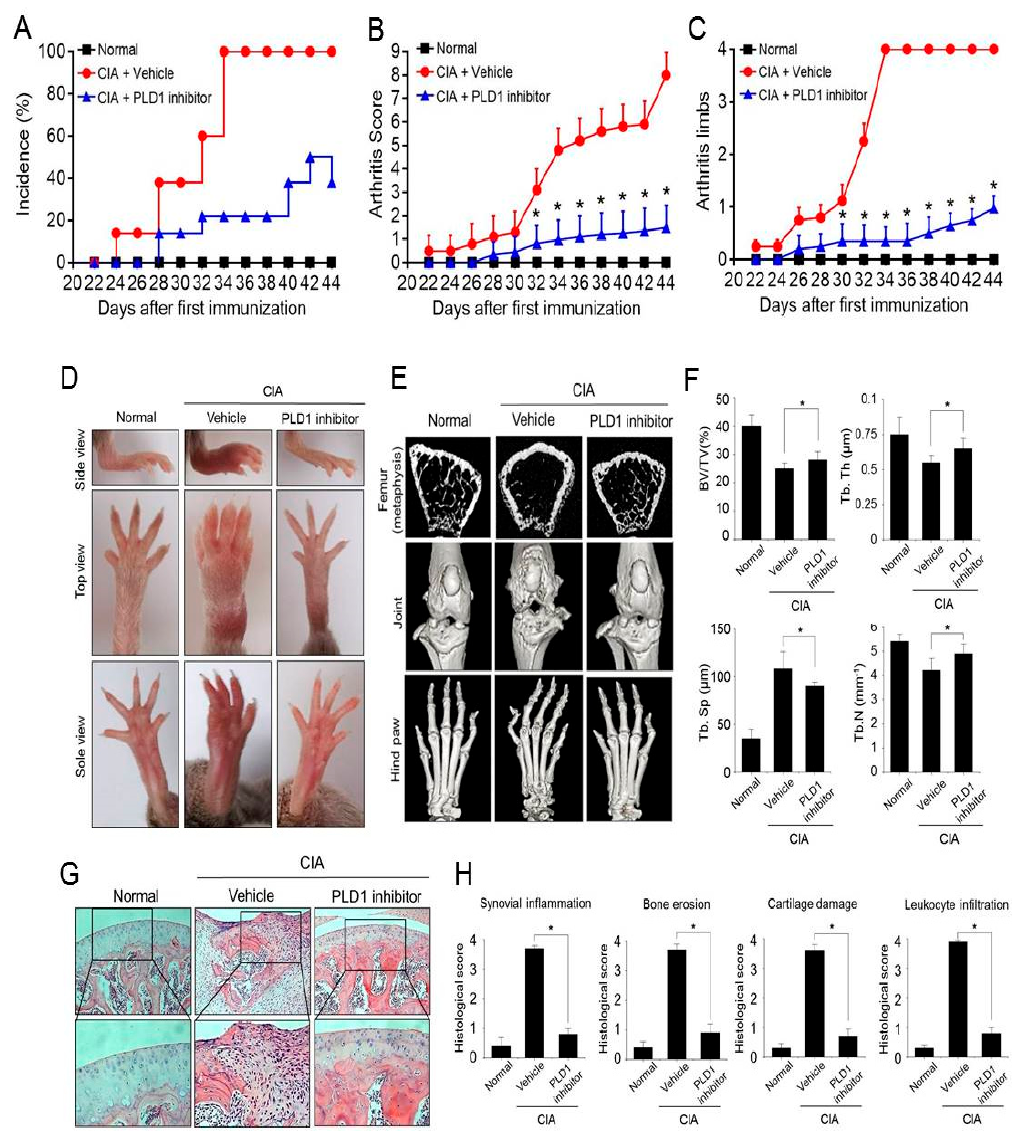
Figure 4. The PLD1 inhibitor ameliorates arthritis and bone erosion in collagen-induced arthritis (CIA) mice. ( A – C ) Effect of the PLD1 inhibitor on the incidence, arthritic score, and the number of affected limbs of CIA mice. DBA/1J mice were immunized on day 0 and boosted on day 21 with type II collagen; intraperitoneal injection of the vehicle or PLD1 inhibitor (5 mg/kg) was done every other day start on day 21 post immunization. The clinical symptoms of the disease including incidence ( A ), arthritic score ( B ), and the number of affected limbs ( C ) were scored. ( D ) Representative photographs showing the gross features of the hind paws at day 45. ( E ) Representative micro-computerized tomography (CT) images of the femurs and knee joints of mice at day 45. ( F ) Effect of the PLD1 inhibitor on the micro-CT parameters of trabecular bone mass in CIA mice at day 45. ( G ) Hematoxylin and eosin staining of knee joints from the indicated mice at day 45. Boxed areas are shown at approximately two times higher magnification. ( H ) Histological assessment of knee joints. n = 15 per group. * p < 0.05. Quantitative results are shown as mean ± standard error of the mean (SEM). 2.5. PLD1 Inhibition Suppresses the Production of Anti-CII IgG2a and Proinflammatory Cytokines in CIA